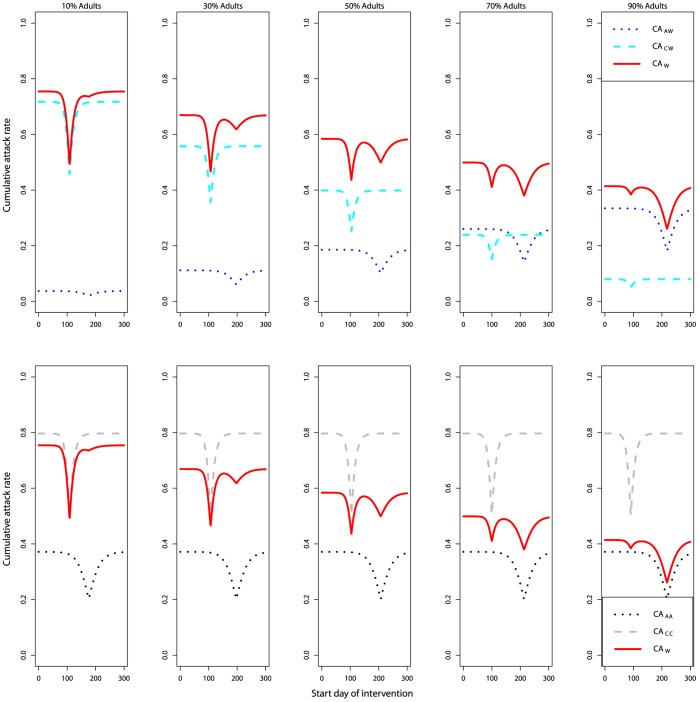
Cumulative attack rates (CA) against the start day of intervention, in the absence of inter-group transmission (βAC = βCA = 0).In the upper row, the denominator in the adults’ and children’s CA is the whole population (SW0 = 1); blue dotted line: CAAW; cyan broken line: CACW; red solid line: CAW = CAAW + CACW. In the lower row, the denominator in the adults’ and children’s CA is their respective proportion in the whole population (SA0 and SC0 respectively); black dotted line: CAAA; grey broken line: CACC; red solid line: CAW = S0A*CAAA + S0C*CACC. Proportion of adults in the population, from left to right: 10%, 30%, 50%, 70% and 90%. Intervention efficacy, fAA = fAC = fCA = fCC = 1. R0A = 1.25, R0C = 2; long intervention; interrupt all routes of transmission. All other parameters and initial conditions are listed in Tables 1 and 2. For the definition of the different cumulative attack rates, please refer to the Materials and Methods section, “Cumulative attack rates”, in the main text.